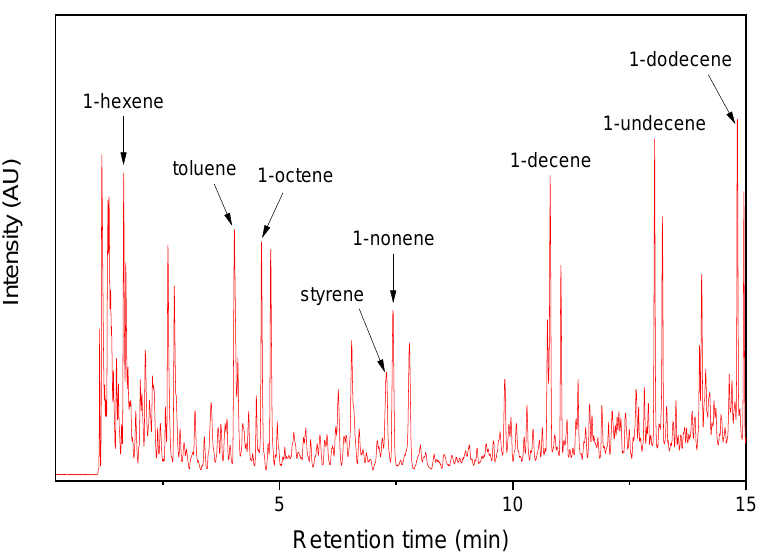
Figure 3. Py-GC/MS chromatogram of the TRWP collected near the PM sampling site.